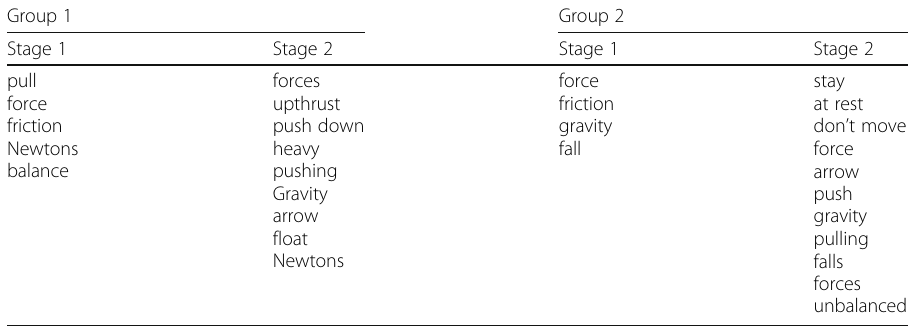
Table 6 Analysis of Meaning Making within Stages 1 and 2 Group